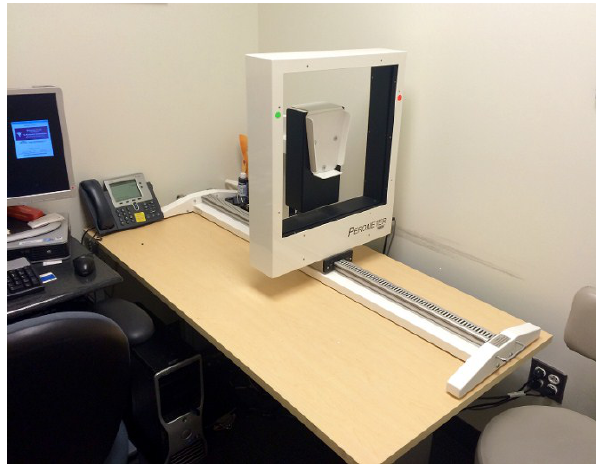
Figure 1. Massachusetts General Hospital (MGH) perometer